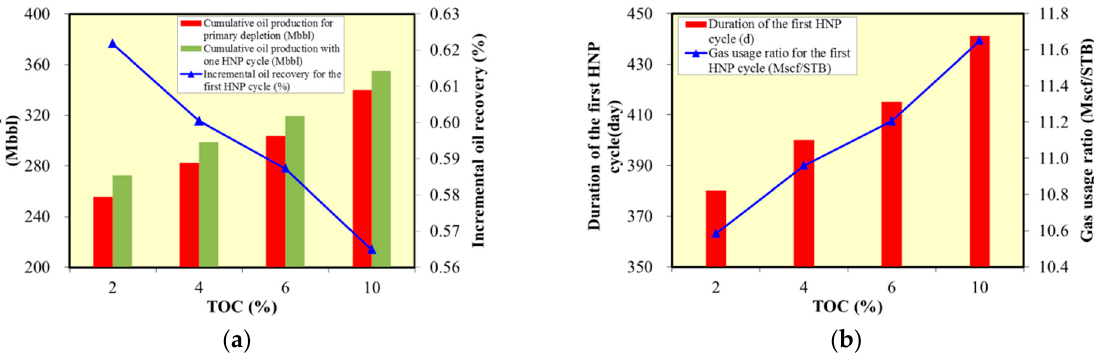
Figure 7. Correlation between TOC and huff-n-puff results: ( a ) Cumulative oil production and incremental oil recovery for different TOC; ( b ) Duration of the first huff-n-puff cycle and gas usage ratio for different TOC.